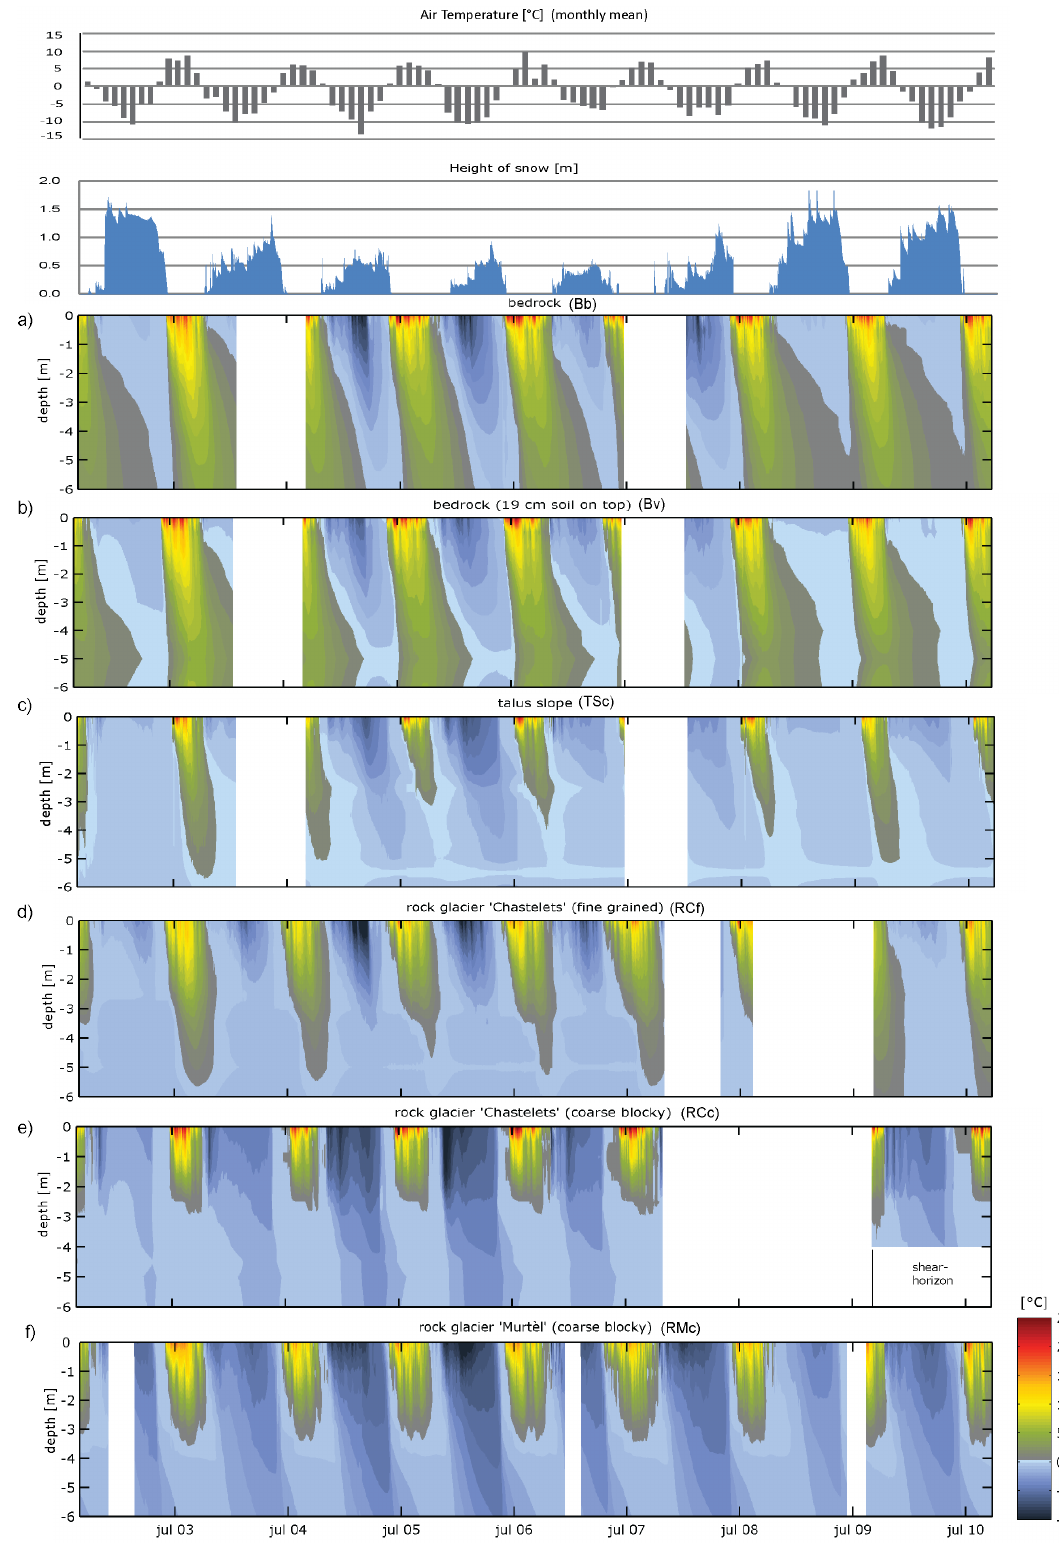
Fig. 3. Monthly mean air temperature, snow height and borehole temperature data from 2002–2010. Air temperature and snow height are measured by the micrometeorological station at the Murt`el rock glacier